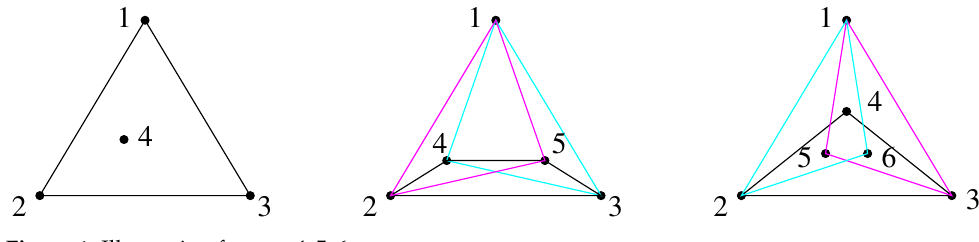
Figure 1. Illustration for n =